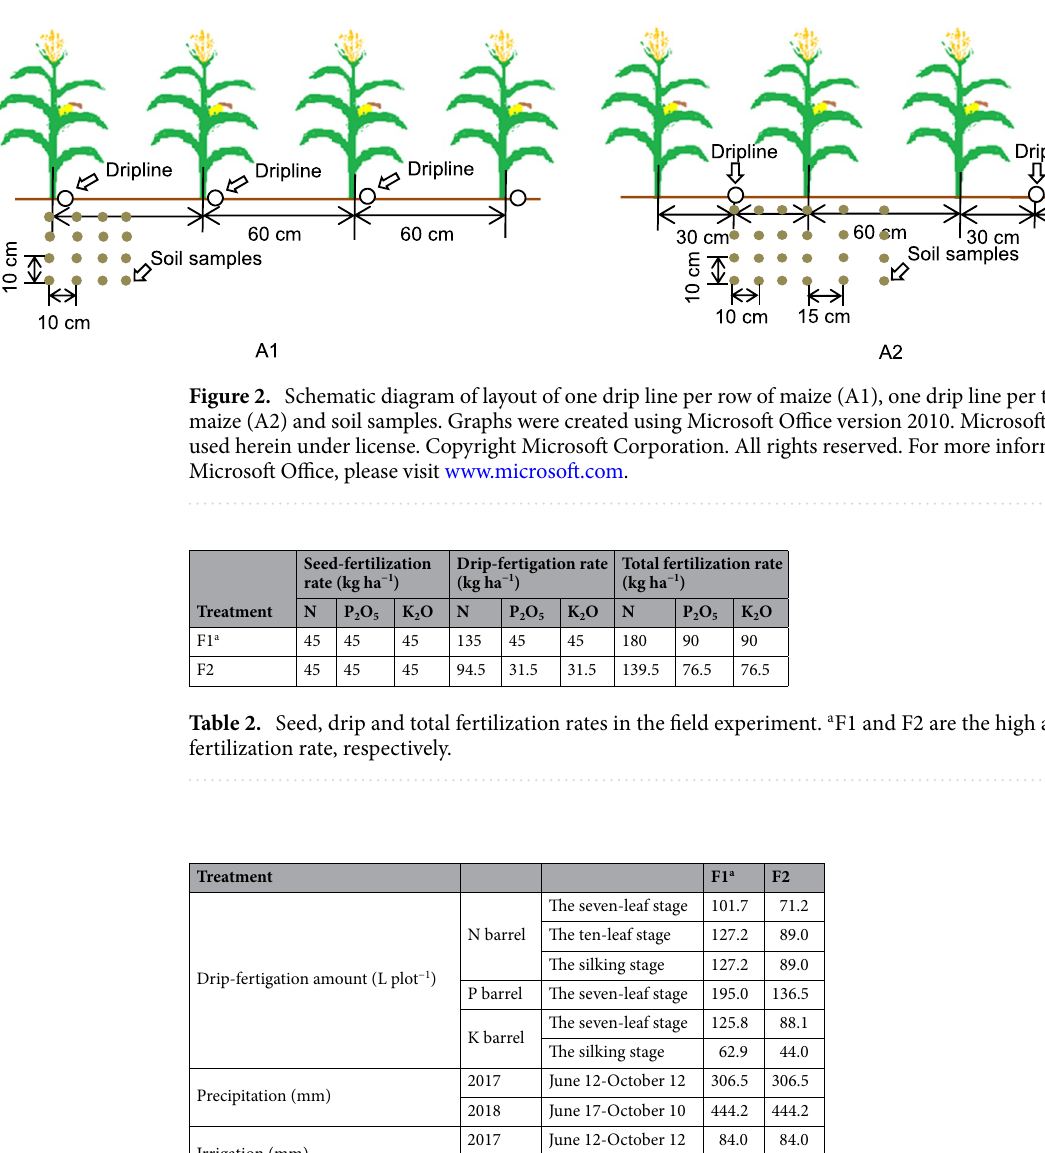
Irrigation Table 3. Fertigation scheduling, precipitation and irrigation amount during summer maize growing seasons. a F1 and F2 are the high and low fertilization rate, respectively.